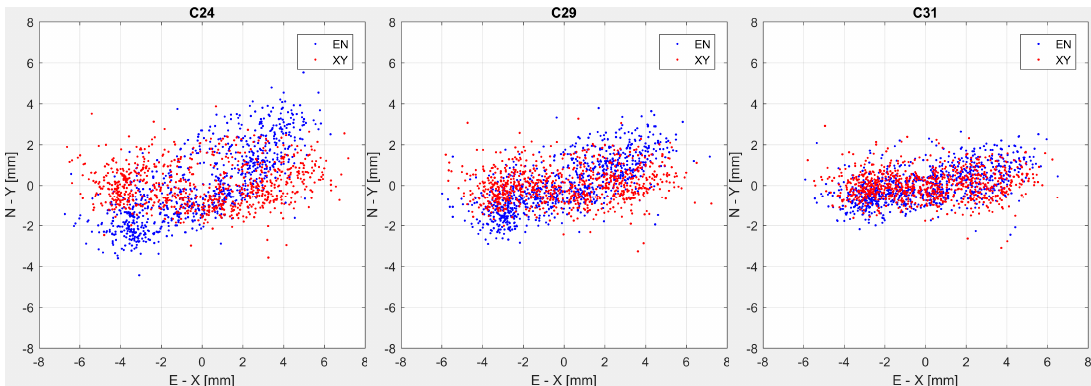
Figure 4. Displacements estimated on ashlars 24 ( left ), 29 ( center ) and 31 ( right ) by GNSS in the East-North (blue dots) and in the X-Y (red dots) reference systems in the period 10 December 2014 to 9 December 2015.